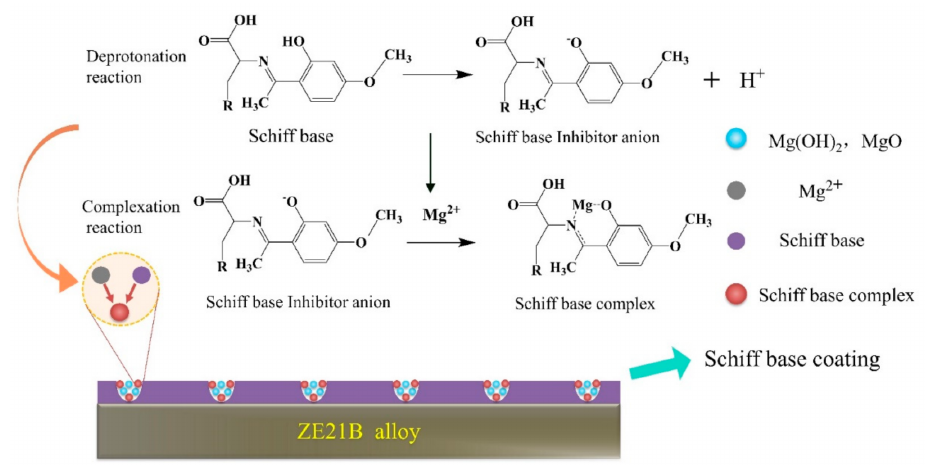
Figure 6. Schematic diagram of corrosion inhibition mechanism of Schiff base